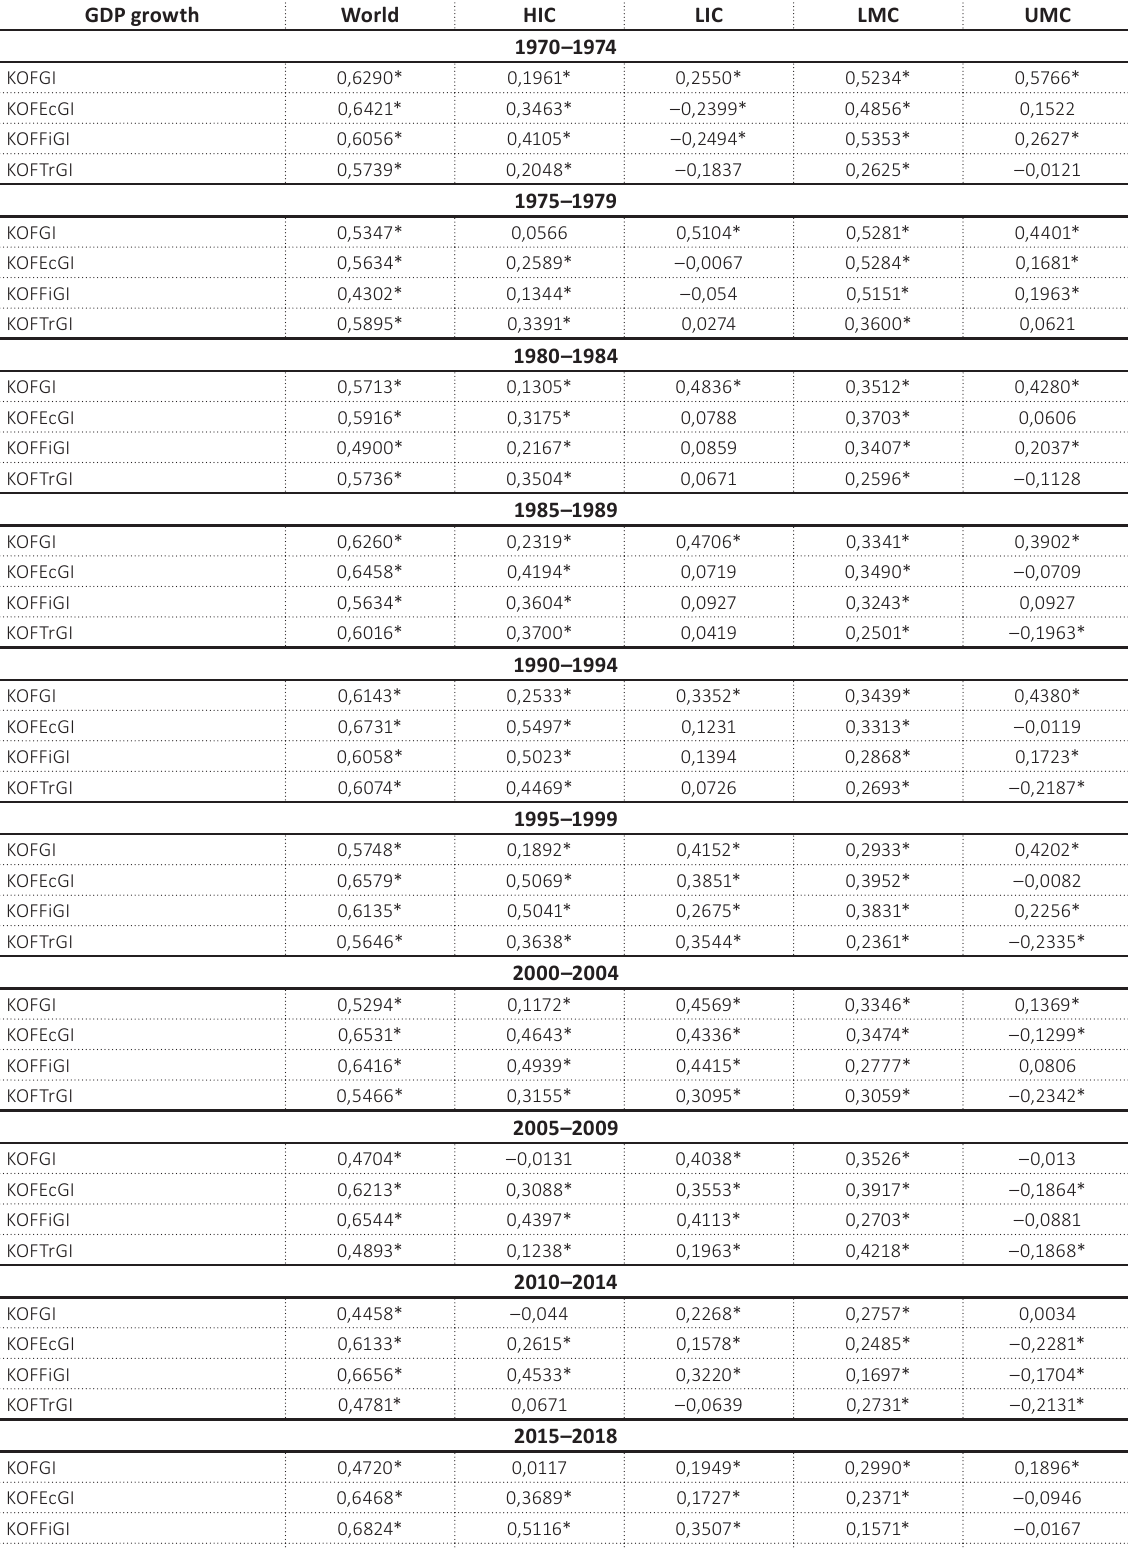
Table C1. Correlation coefficients between real GDP growth and KOF indices of globalization GDP